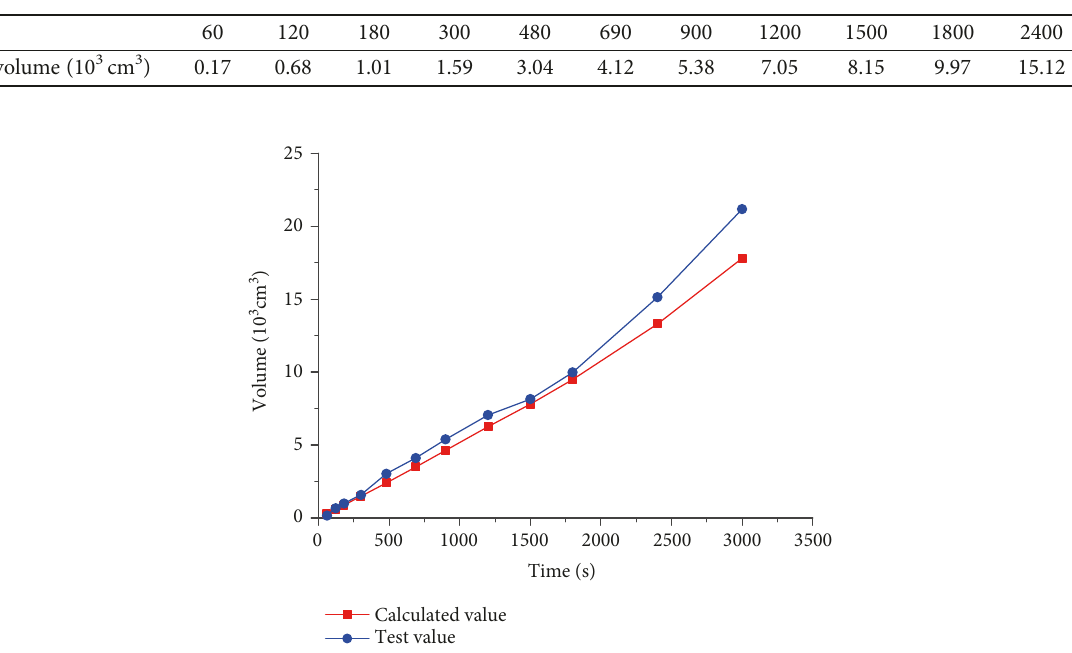
Figure 7: Local position photos of the tunnel and the plug in the physical Table 6: Seepage volume at di ff erent times.